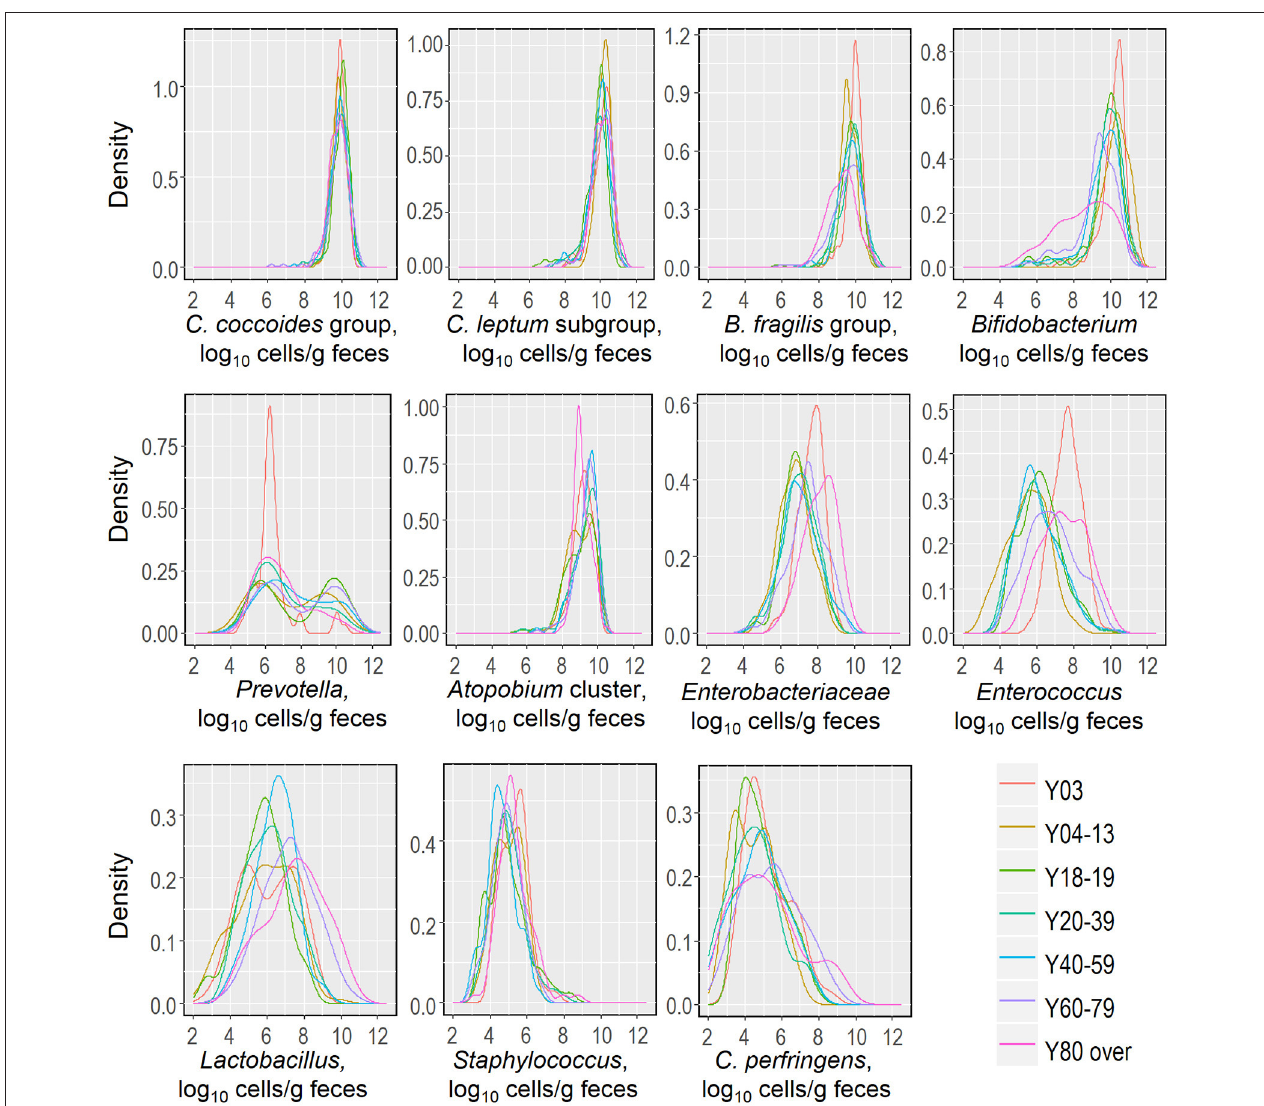
FIGURE 3 | Distributions of fecal counts of major intestinal bacterial groups in healthy Japanese subjects aged 3 years or older ( n = 1116).